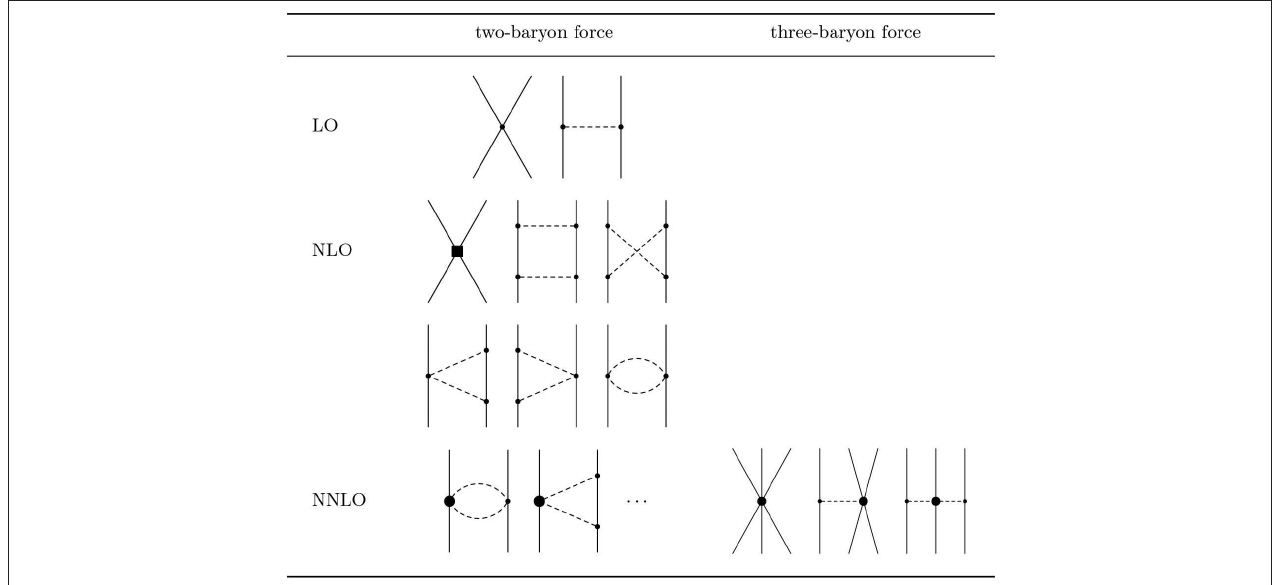
FIGURE 5 | Hierarchy of baryonic forces. Solid lines are baryons, dashed lines are pseudoscalar mesons. Solid dots, filled circles, and squares denote vertices with 1 i 0,1, and 2, respectively. =